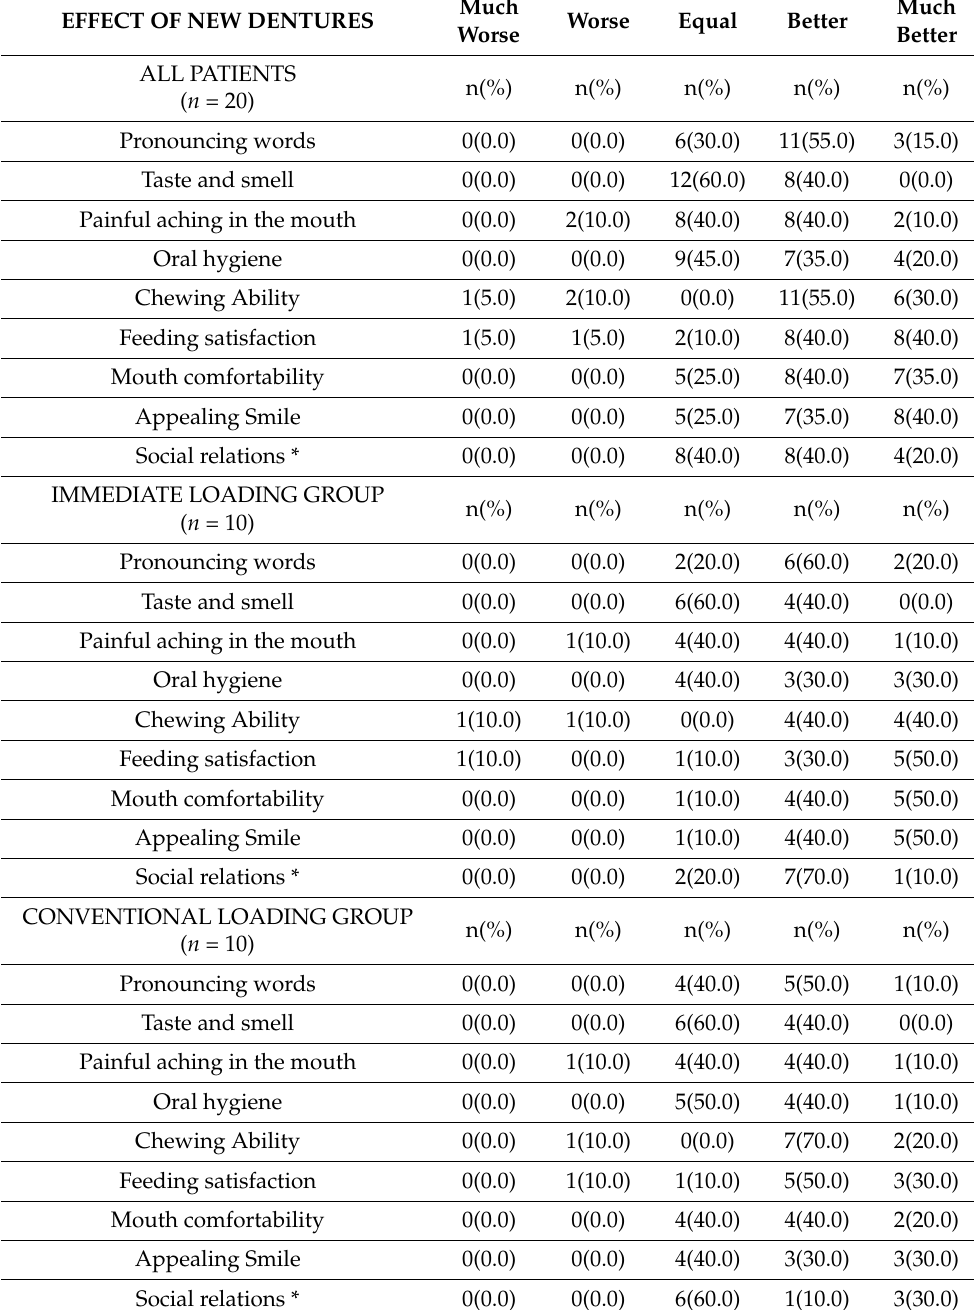
Table 10. Retrospective evaluation of the prosthetic treatment (new denture) by global transition items in the whole sample ( n = 20) and within loading